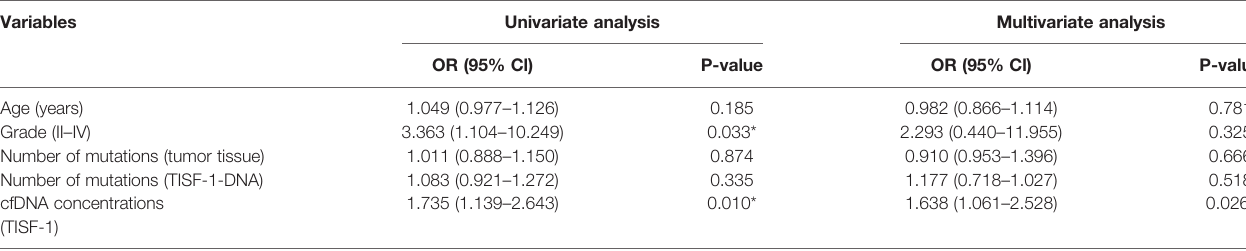
TABLE 2 | Multivariate analysis identi fi ed patients at high risk of worse PFS.